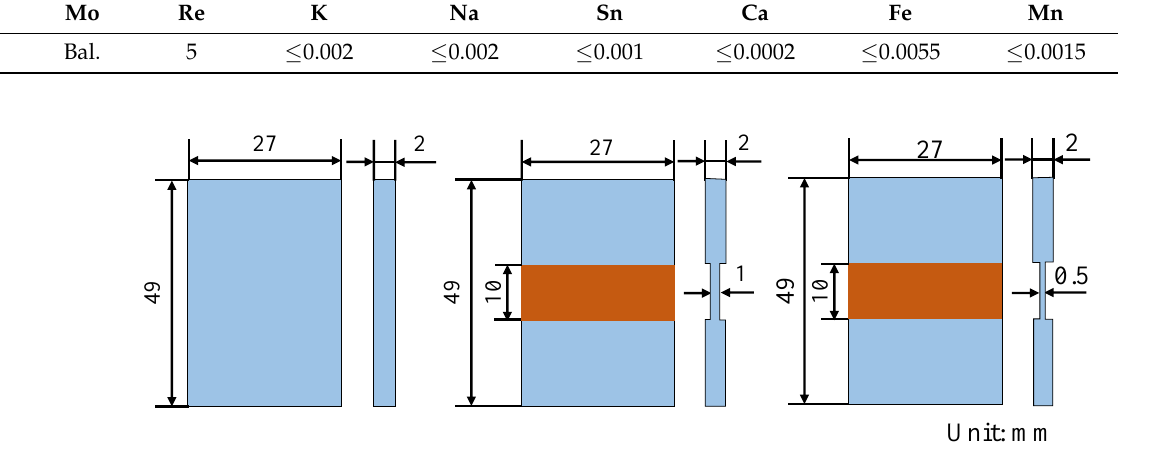
Figure 1. The specific dimensions of Mo – 5Re sheets with thicknesses of 2 mm, 1 mm, and 0.5 mm.